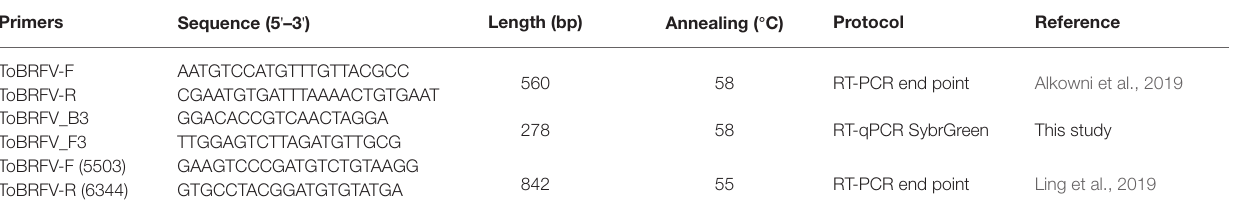
TABLE 2 | Primers used for conventional RT-PCR and RT-qPCR amplification for comparison with the RT-LAMP method proposed in this study.